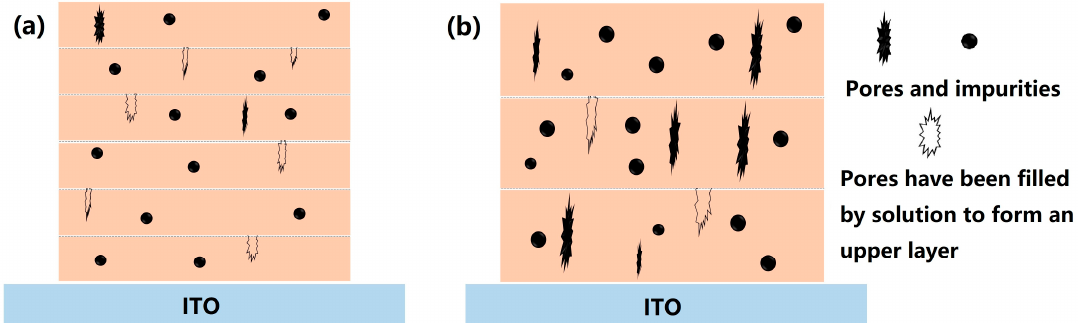
Figure 12. Cross-sectional schematic diagrams of ZrO 2 films. ( a ) 0.3 M precursor spin-coating 6 times. ( b ) 0.6 M precursor spin-coating 3 times. The interfacial pores and pinholes in the sublayer filled by solution to form an upper layer.